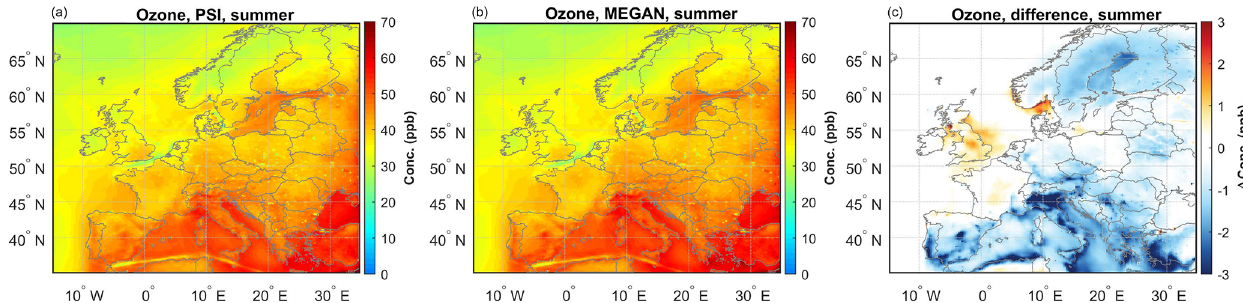
Figure 6. Modelled afternoon (12:00–18:00UTC) mixing ratios of surface ozone in summer using PSI emissions (PSI O 3 , a ), MEGAN emissions (MEGAN O 3 , b ), and the difference between PSI O 3 and MEGAN O 3 (c) .